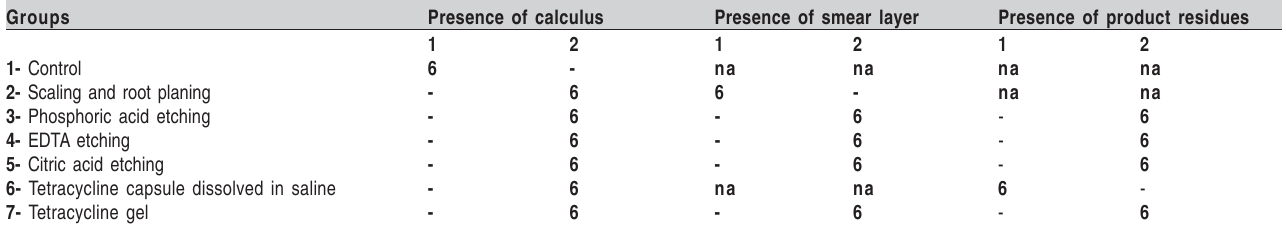
Table 1. Parameter scores evaluated by scanning microscopy analysis for all groups